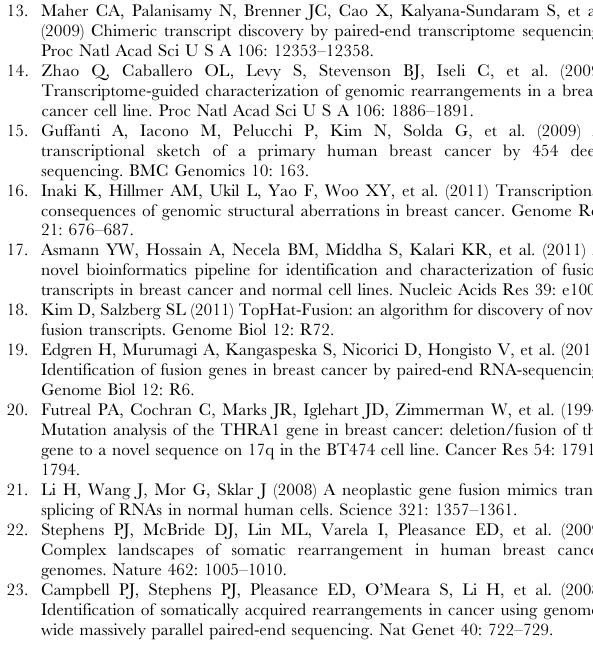
Intrachromosomal (red) and interchromosomal (blue) fusions are indicated by arcs. Copy number profiles are plotted in the inner circle. Amplifications are shown in red and deletions in blue. N denotes the number of fusion genes per cell line. (TIF) Figure S2 Genomic rearrangements underlying fusion gene formation in MCF-7. Circos plot illustrating all chromosomal translocations in MCF-7 reported by us here and previously [19]. Chromosomes are drawn into scale around the rim of the circle and data are plotted on these coordinates. Intrachromosomal (red) and interchromosomal (blue) fusions are indicated by arcs. Copy number profiles are plotted in the inner circle. Amplifications are shown in red and deletions in blue. N denotes the number of fusion genes per cell line. (TIF) Figure S3 Several fusion transcripts have multiple splice variants in MCF-7. Transcript variants of MCF-7 fusion genes GCN1L1-MSI1, SMARCA4-CARM1 and AC099850.1- TMEM49 are presented. Multiple splice variants are visible as RT- PCR bands, and schematically represented by the arrows to the left. Chromatograms show the actual cDNA sequence break points of the main predicted fusion isoforms, and are connected with lines to the corresponding RT-PCR bands. Gray arrows = coding sequence, white arrows = untranslated exon or 3 9 /5 9 UTR, thin lines connecting exons = intronic regions. 5 9 partner genes are represented by brown color, 3 9 partner genes by green. Figure S4 Several fusion transcripts have multiple splice variants in BT-474. Transcript variants of BT-474 fusion genes USP32-MED1, PIP4K2B-RAD51, AHCTF1-NAAA, MED13-BCAS3 and MED1-ACSF2 are presented. Multiple splice variants are visible as RT-PCR bands, and schematically represented by the arrows to the left. Chromatograms show the actual cDNA sequence break points of the main predicted fusion isoforms, and are connected with lines to the corresponding RT- PCR bands. Gray arrows = coding sequence, white arrows =